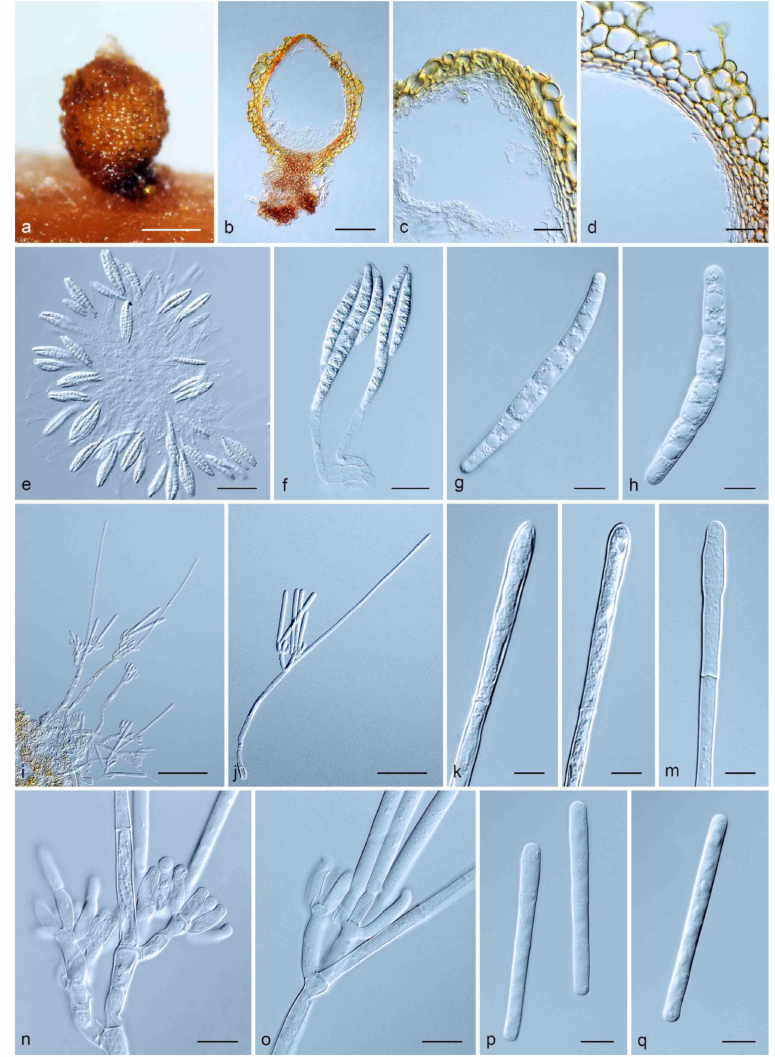
Figure 4. Calonectria minensis . ( a ) Perithecium; ( b ) vertical section through a perithecium; ( c ) cells around ostiolar region of perithecium; ( d ) section through lateral perithecial wall; ( e , f ) asci; ( g , h ) ascospores; ( i , j ) macroconidiophore; ( k , m ) clavate vesicles; ( n , o ) conidiogenous apparatus with conidiophore branches and elongate doliiform to reniform phialides; ( p , q ) macroconidia.—Scale bars: a = 200 µ m; b = 100 µ m; c, d and f = 20 µ m; e and i, j = 50 µ m; g, h and n–q = 10 µ m; k, m = 5 µ